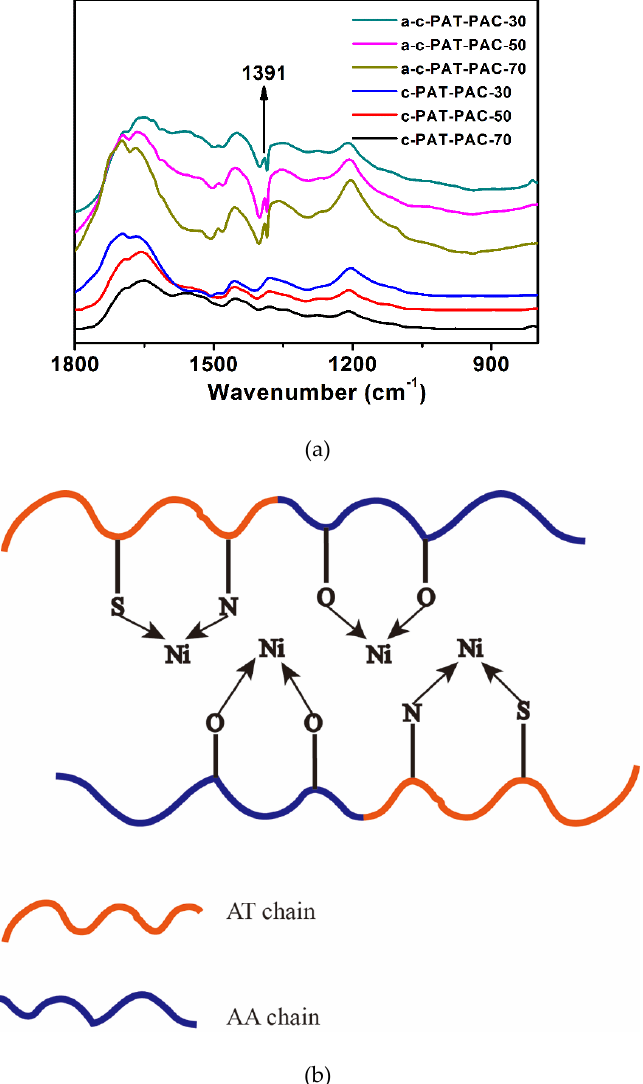
Figure 8. ( a ) FTIR of the chemical structure changes after Ni(II) adsorption within the spectral ranges of Figure 8. (a) FTIR of the chemical structure changes after Ni(II) adsorption within the 1800–800 cm − 1 and ( b ) schematic representation of the chelation cross-link reaction between PAT–PAC spectral ranges of 1800–800 cm − 1 and (b) schematic representation of the chelation cross-link adsorbents and Ni(II). AT is allylthiourea, AA is acrylic reaction between PAT–PAC adsorbents and Ni(II). AT is allylthiourea, AA is acrylic acid.